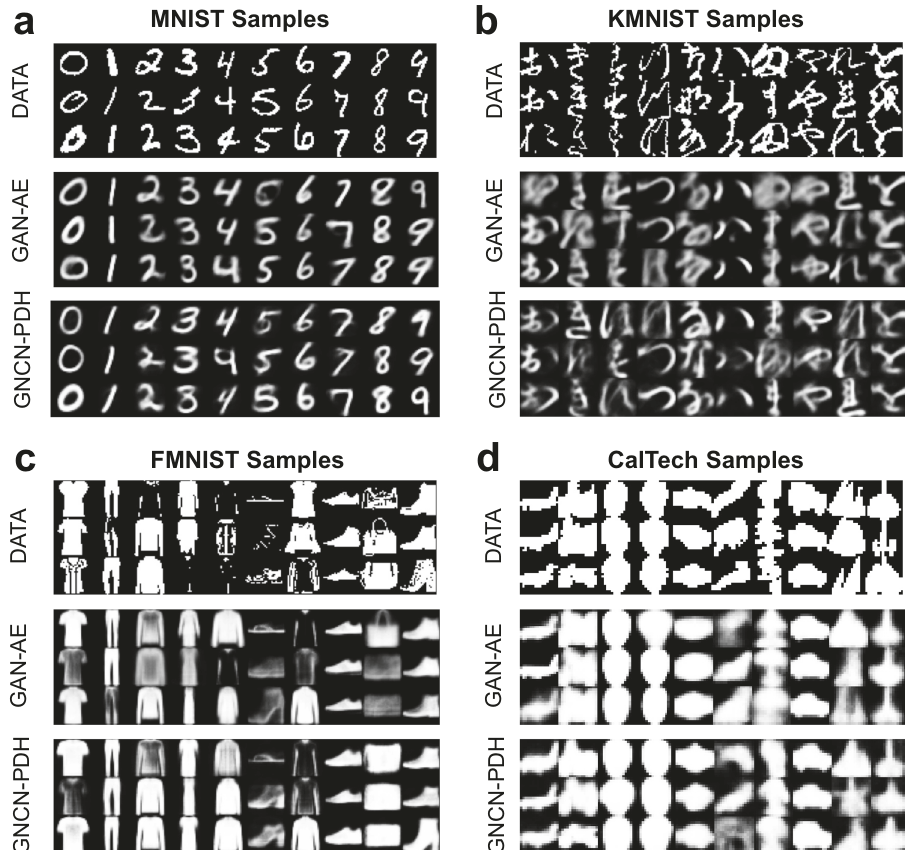
Fig. 5 Model sample visualization. Shown are samples from models with overall best BCE-log p ð x Þ balance (each column corresponds to one class). Top row shows dataset samples (DATA), middle row shows adversarial autoencoder (GAN-AE), and bottom row shows neural generative coding (GNCN- PDH) samples. Columns are arranged, left to right, as: a MNIST, b KMNIST, c FMNIST, and d